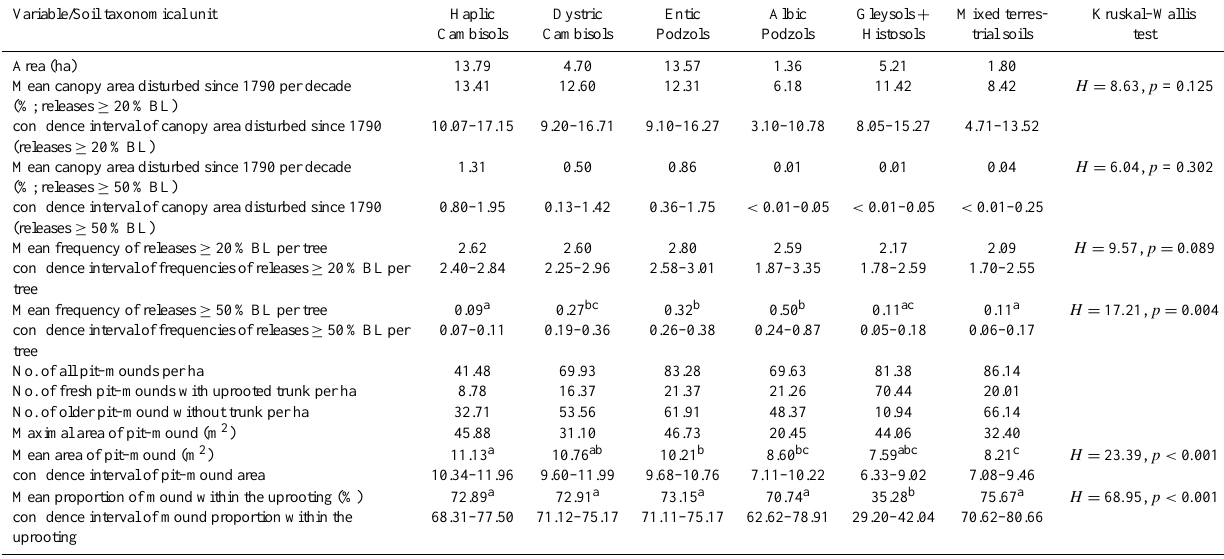
Table 1. Descriptive statistics of selected characteristics of disturbances in relation to main soil taxonomical units in the Žofín core zone. Box–Cox transformation and Kruskal–Wallis test were applied (within a row, numbers with different letters significantly differ at α = 0 . 05). All confidence intervals are 95%.